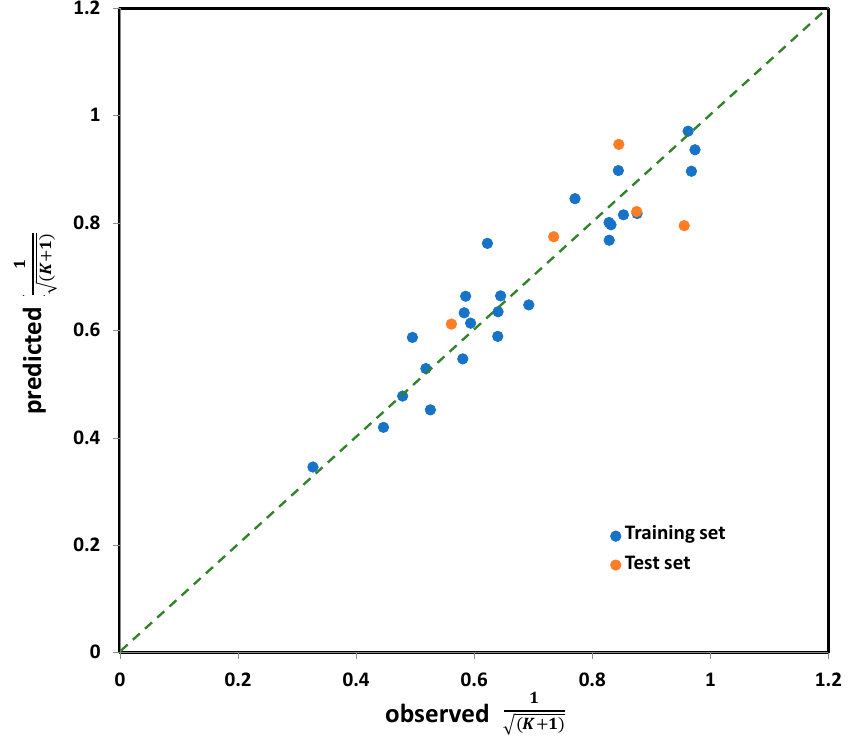
Figure 4. The observed vs. predicted values for K coefficient (in transformed 1 √ (cid:2869) entire set (30 compounds) calculated by five-variable model, selected as the best one among all tested.